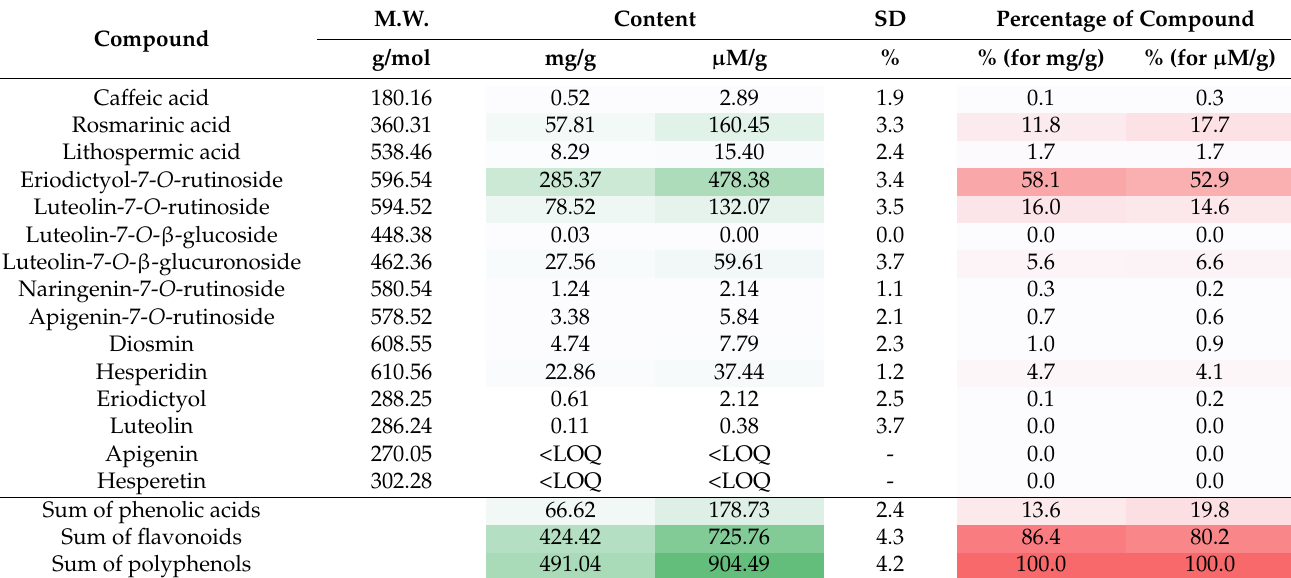
Table 2. Content of key polyphenols in peppermint leaf dry extract determined by HPLC-DAD (as